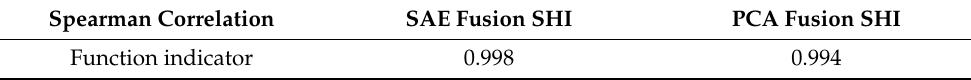
Table 2. Correlation analysis of SHI and function indicator.